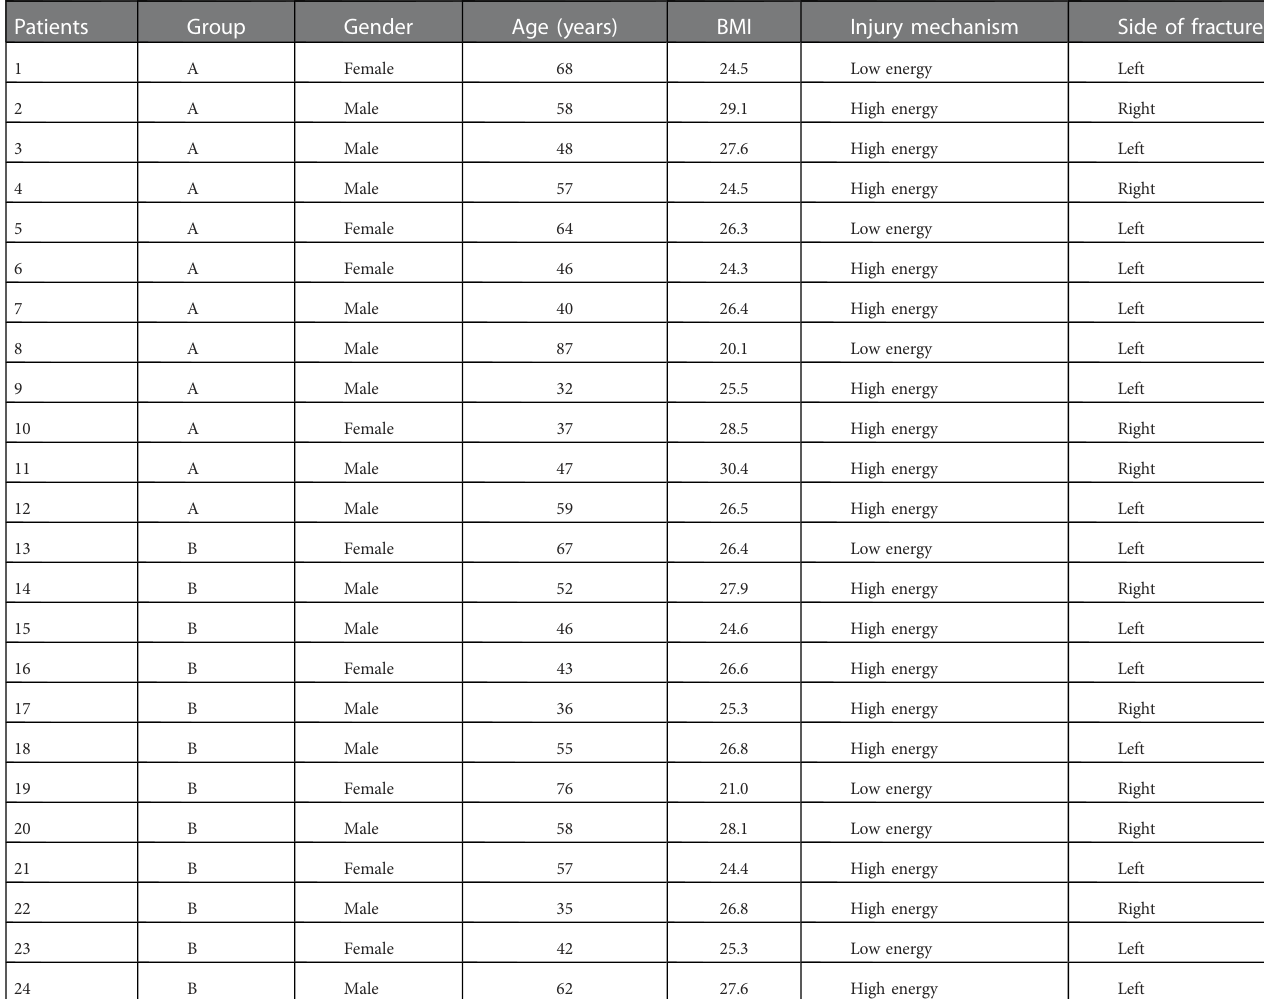
TABLE 1 Demography and fracture-related characteristics.